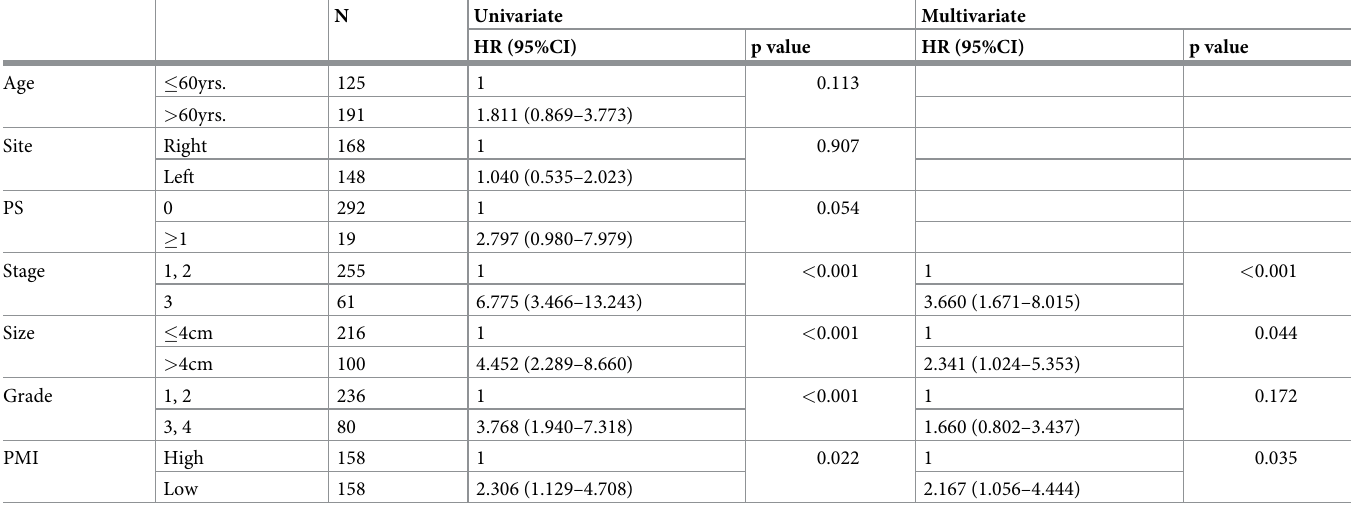
Table 3. Recurrence risk factor within 5 years after nephrectomy.